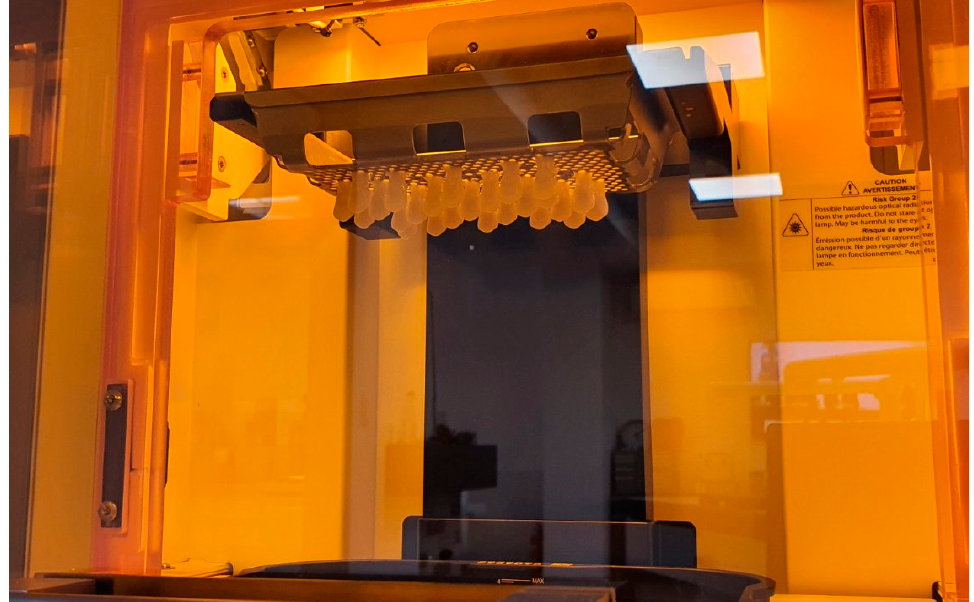
Figure 2. Three-dimensional printing of the artificial teeth: dental resin material NextDent C&B MFH (NextDent 3D Systems, Soesterberg, The Netherlands) is placed into the 3D printer NextDent 5100 (NextDent, 3D Systems, Soesterberg, The Netherlands).